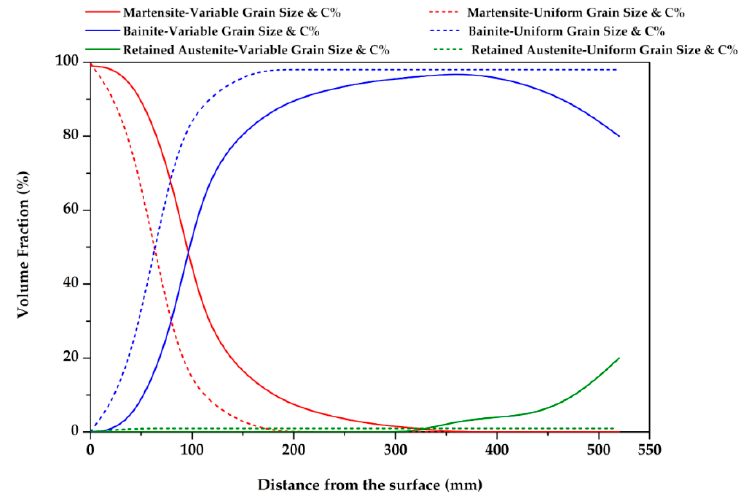
Figure 10. Effect of variable grain size and carbon concentration on the predicted phase distribution along the depth of the block after water-quenching process. Dashed line condition (A); Solid line condition (D).